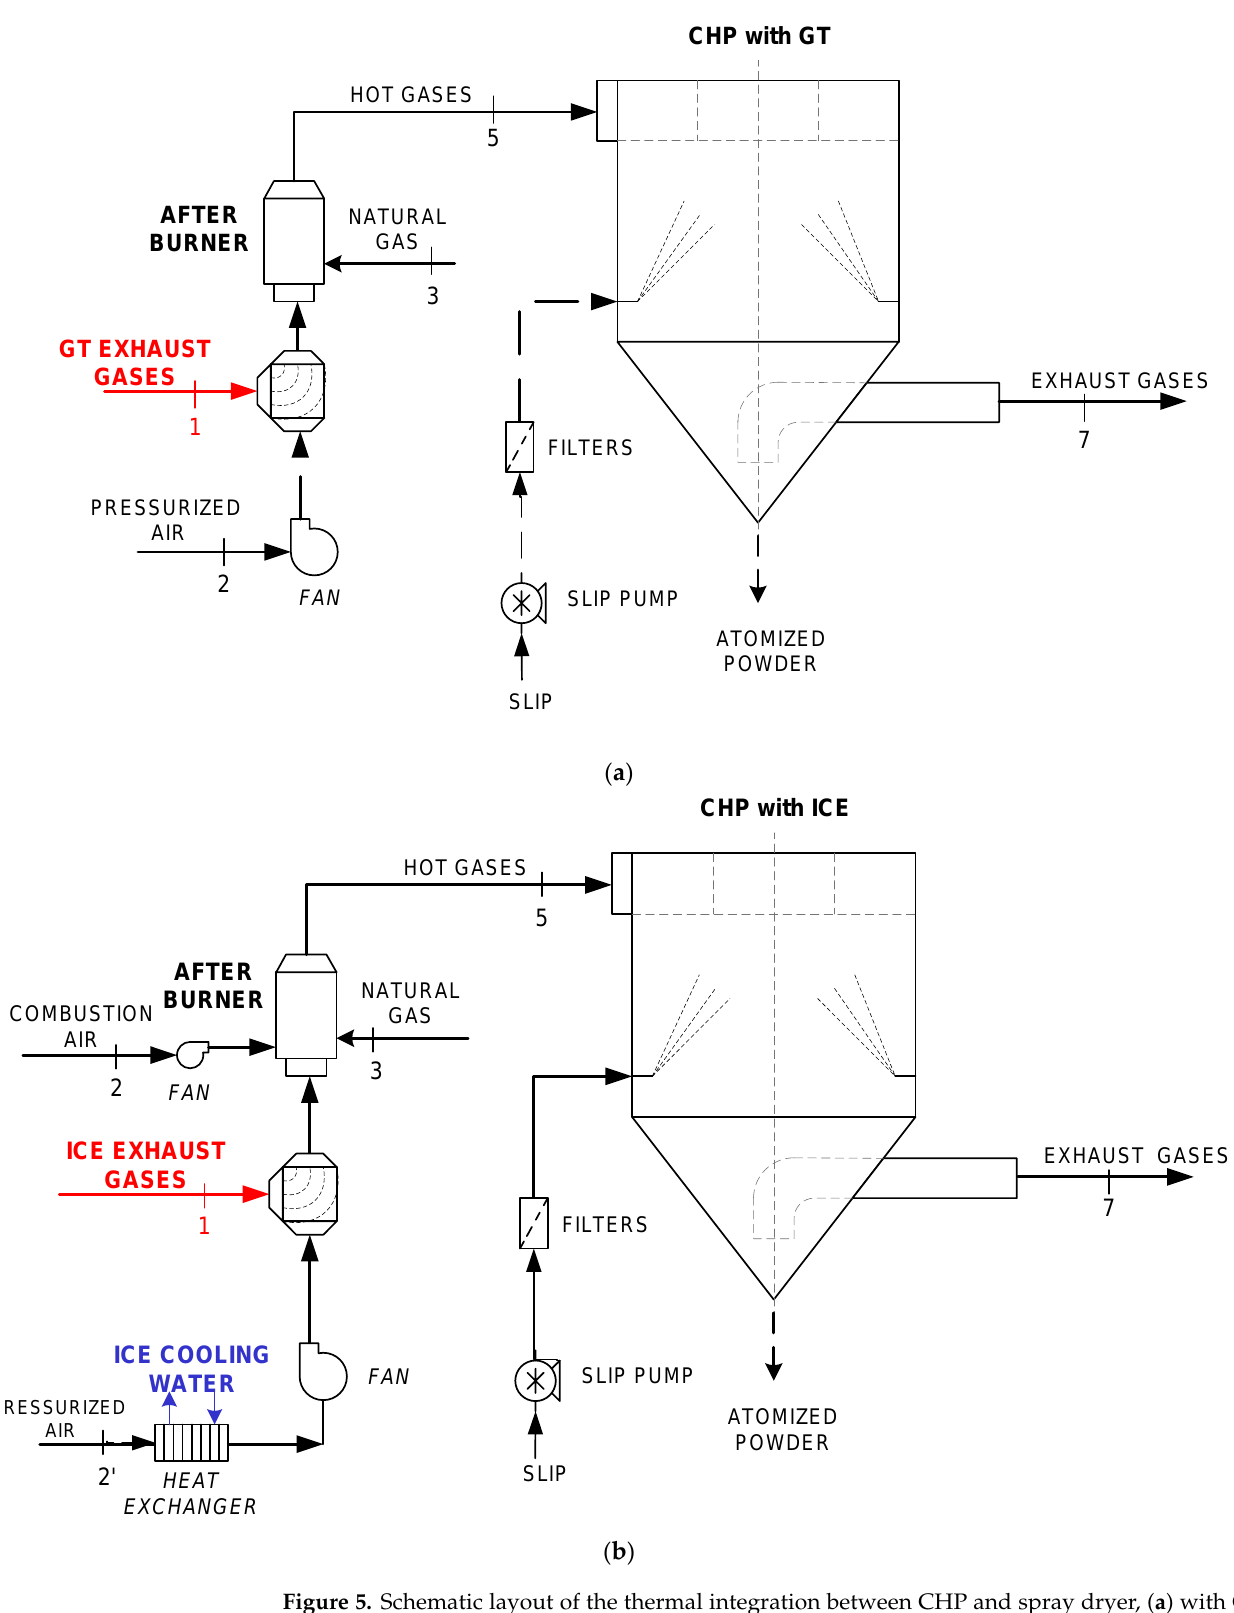
Figure 5. Schematic layout of the thermal integration between CHP and spray dryer, ( a ) with GT, ( b ) with ICE.